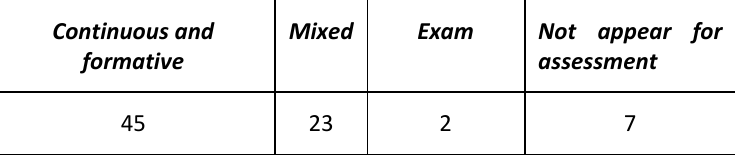
Table 6. Number of students choosing each assessment